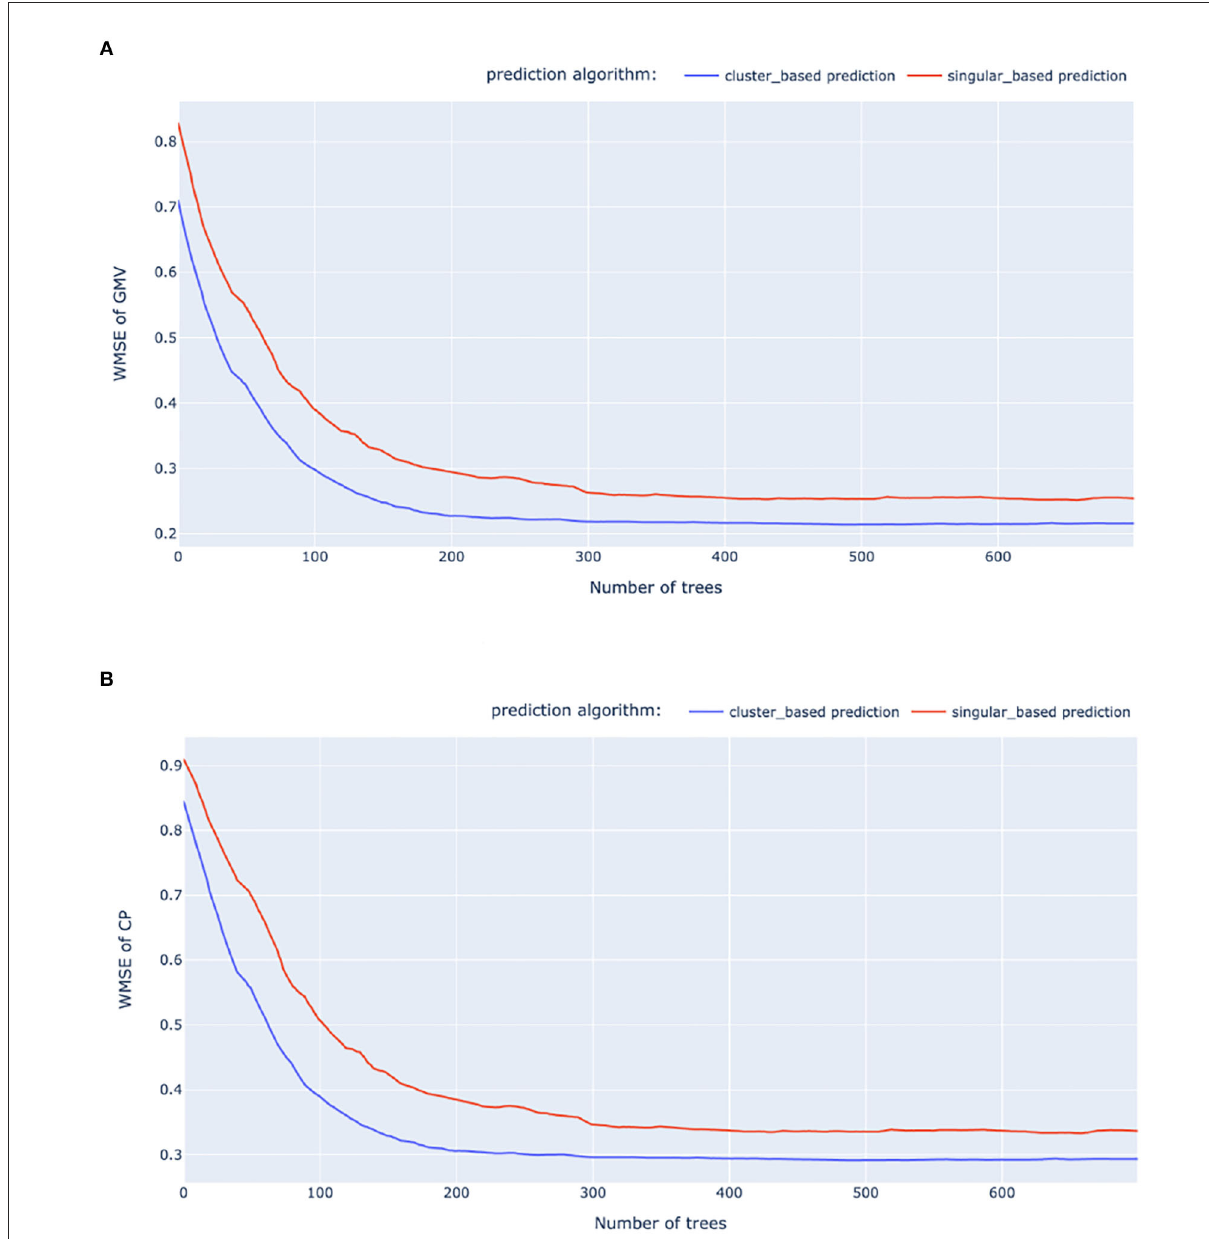
FIGURE7 Relative WMSE of the baseline and our approach when using GBRT. (A) GMV WMSE. (B) CP WMSE.